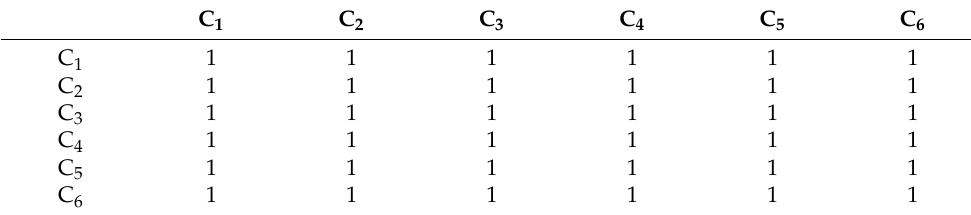
Table 9. Influence matrix of the revised NK